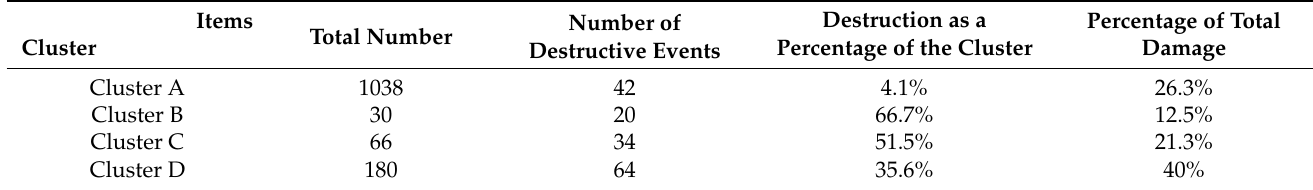
Table 21. Statistics relevant to the destruction ratio of each cluster.